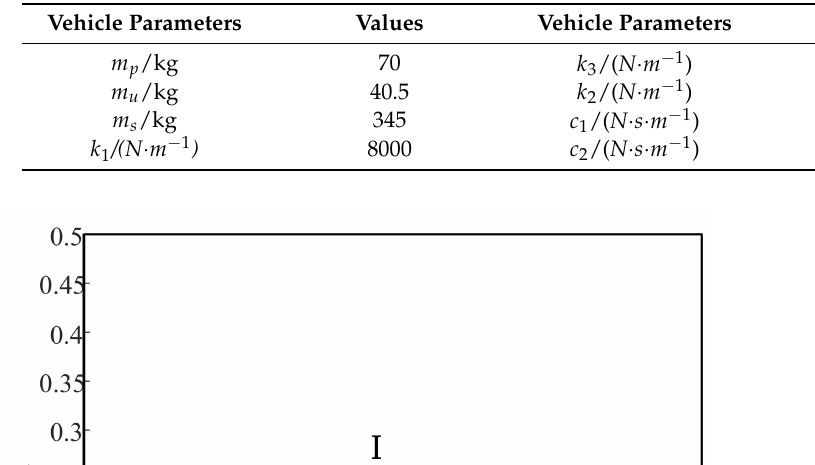
Table 1. Vehicle suspension model parameters.